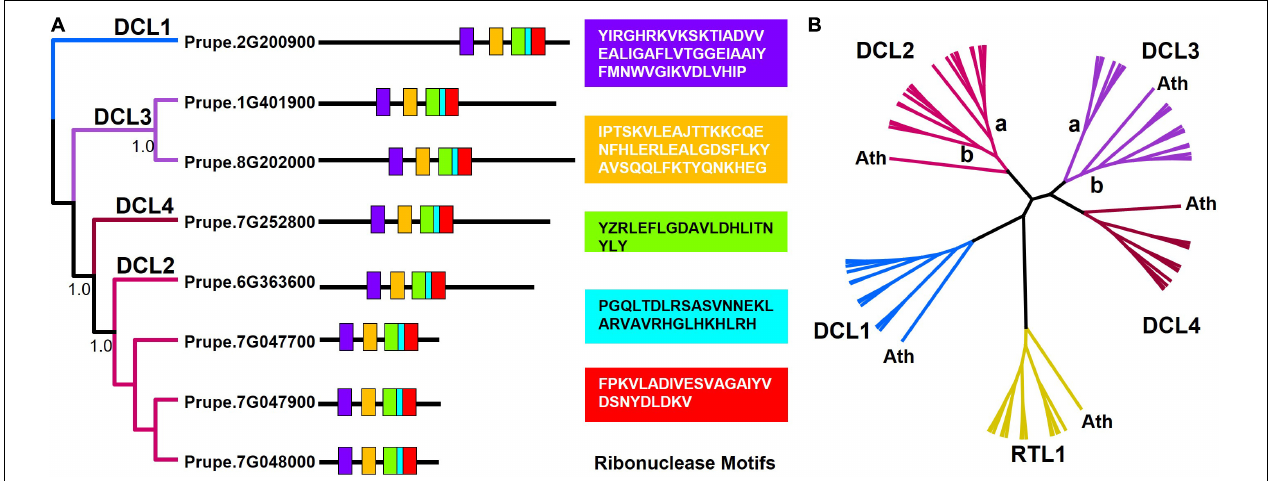
FIGURE 1 | Conserved motifs of Prunus persica DCLs genes. (A) Gene structure and domain compositions of P. persica DCLs based on the presence of conserved Ribonuclease motifs (detailed in colored boxes) were arranged and clustered in four groups. (B) Unrooted maximum likelihood DCL phylogenetic tree shows the RTL1 gene outgroup, and A. thaliana species outgroup along the NCBI BLAST top 10 hits of P. persica DCL copies. A unique cluster is observed for DCL1, and DCL4, while both DCL2 and DCL3 were separated into two subclades.